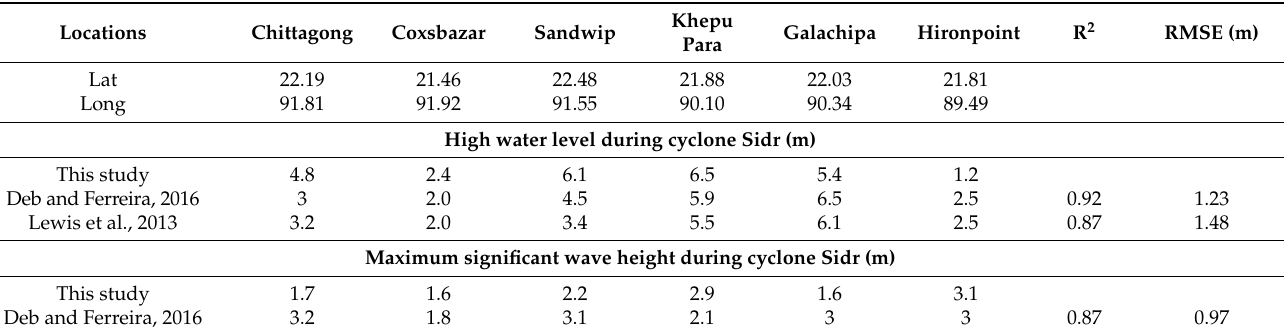
Table 4. Comparison of model outcomes with high water levels and max. significant wave height extracted from recent studies on Cyclone Sidr.